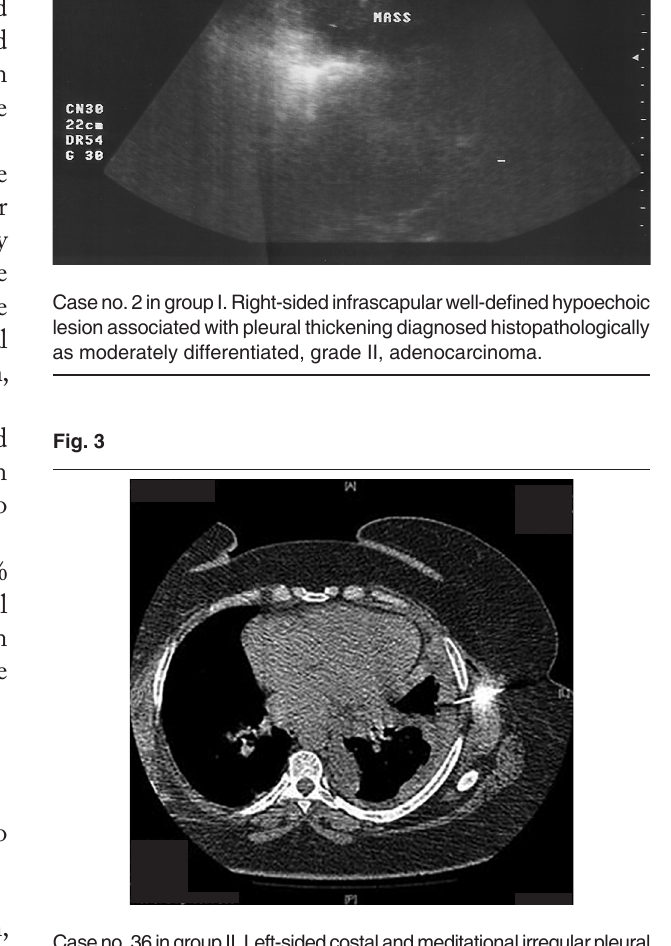
Case no. 36 in group II. Left-sided costal and meditational irregular pleural thickening with encysted pleural effusion and ipsilateral meditational shift diagnosed histopathologically as malignant